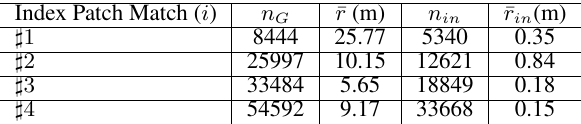
Table 1. Accuracies obtained by running the patch-based local alignment procedure on the dataset Fabas, with N = 4 homologous patches; n G : the number of 3D points representing the ground (input), n in : the number of inliers output by the pose estimation procedure.